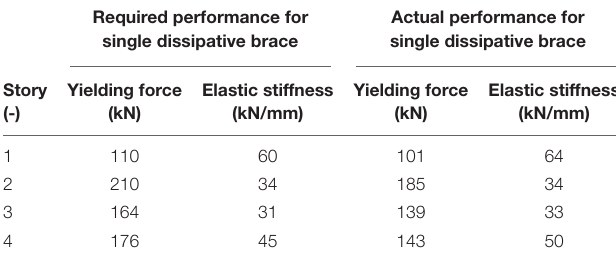
TABLE 1 | Required vs. actual performance for single dissipative brace in horizontal direction.